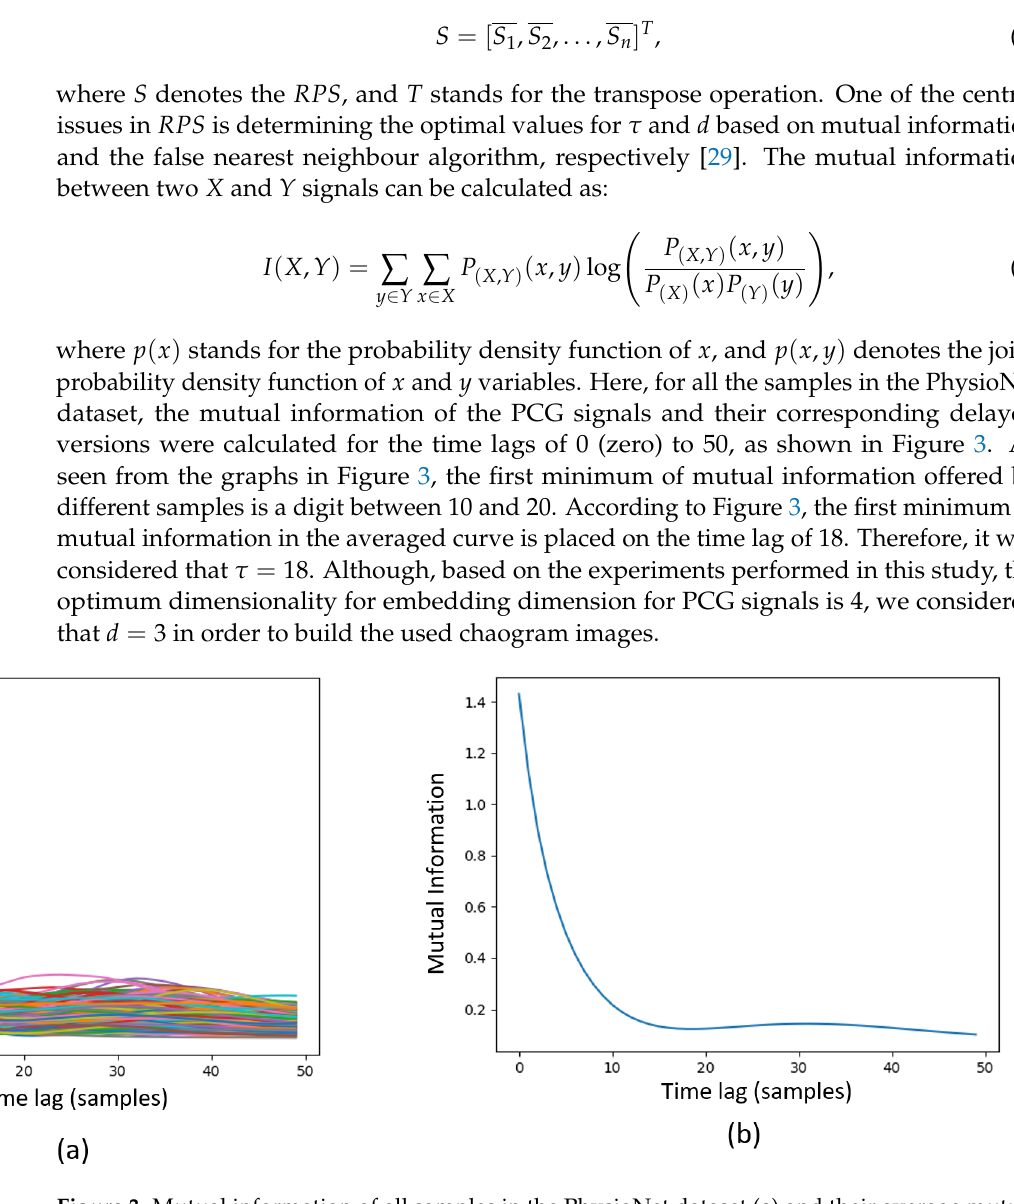
Figure 3. Mutual information of all samples in the PhysioNet dataset ( a ) and their average mutual information ( b